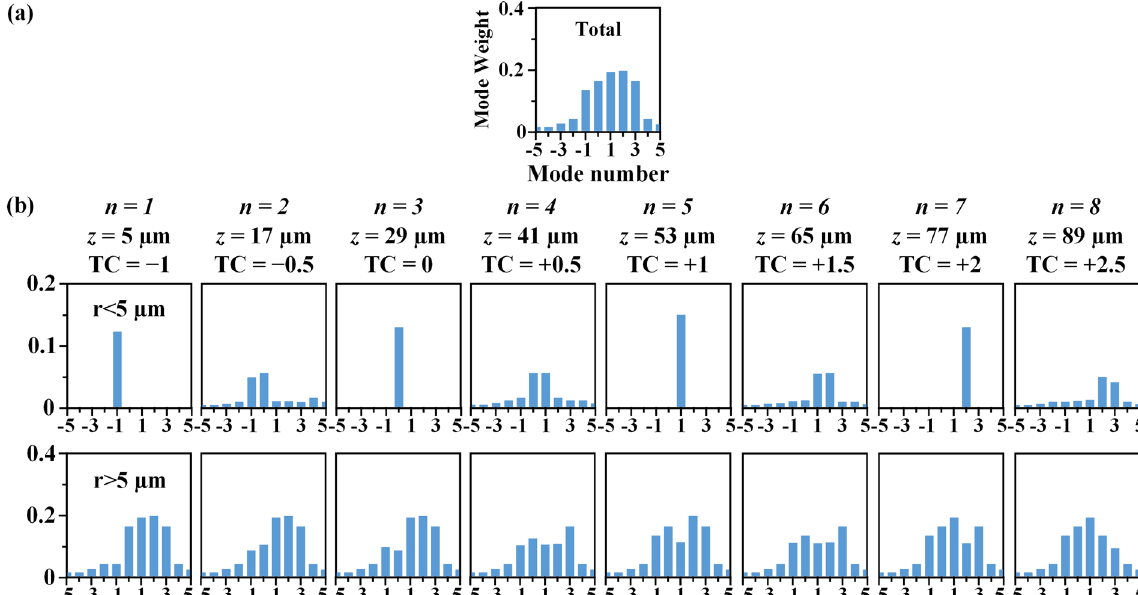
Figure 4. Calculated distributions of OAM mode at different z ( n ). ( a ) The total OAM mode distribution. ( b ) The dynamic distributions of OAM mode within the beam inner region of r < 5 µ m (top row) and the beam outer region of r > 5 µ m (bottom